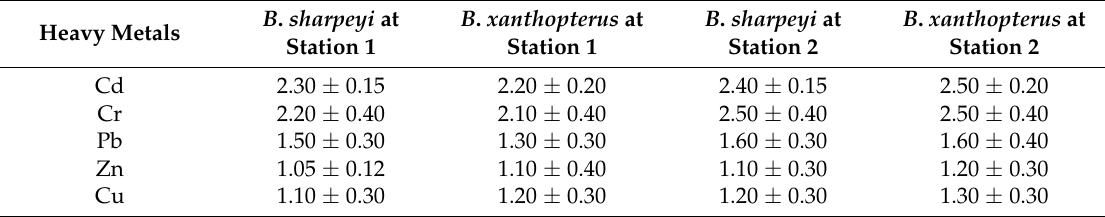
Table 1. Mean concentrations of heavy metals ( µ g/g) in the gills of Barbus sharpeyi and Barbus xanthopterus at Station 1 and Station 2.